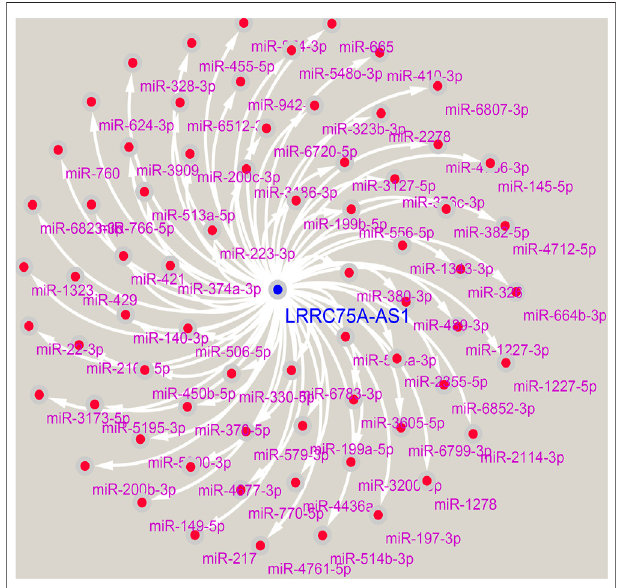
FIGURE 4 | Construction of a LRRC75A-AS1-miRNA regulatory.